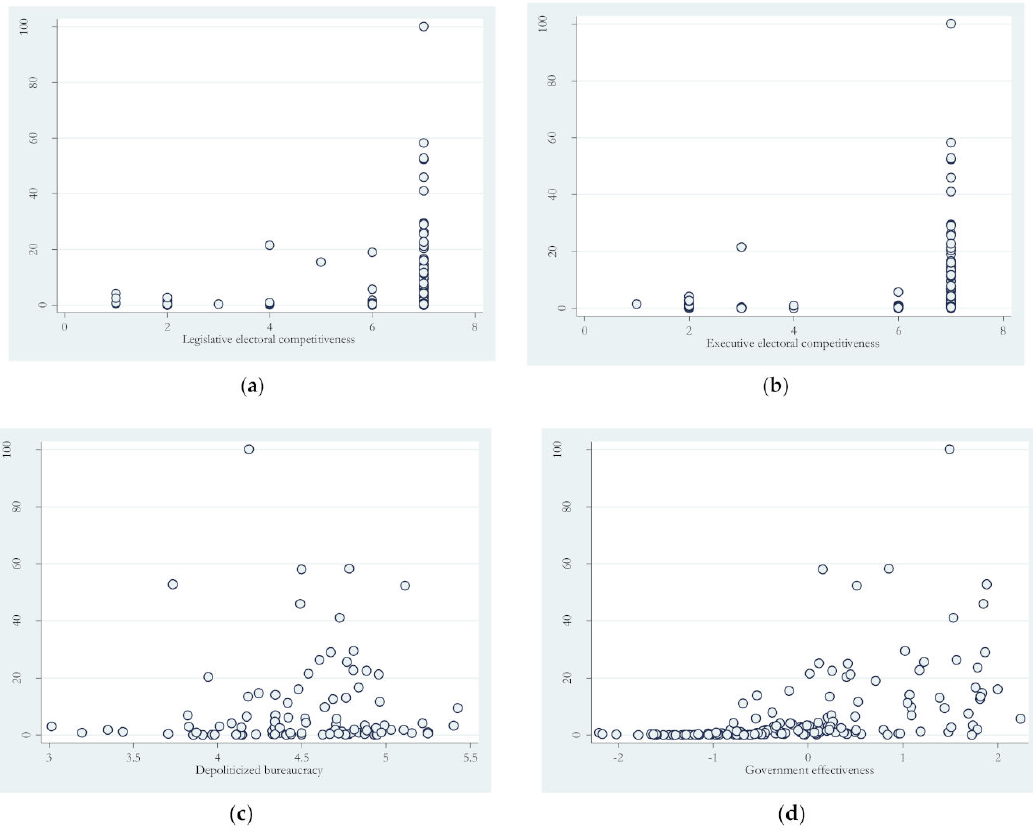
Figure 2. Associations between government qualities and sharing economy. ( a ) sharing economy development and legislative electoral competitiveness; ( b ) sharing economy development and executive electoral competitiveness; ( c ) sharing economy development and depoliticized bureaucracy; ( d ) sharing economy development and government e ff